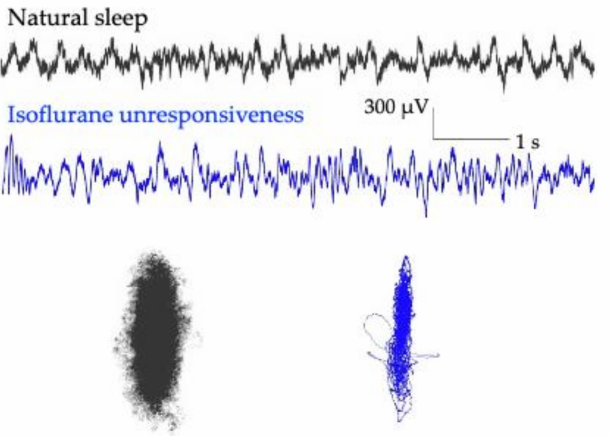
Figure 3. Rodent prefrontal local field potential activity and three-dimensional attractors during natural sleep and anesthesia. Local field potentials show less high frequency activity and more pronounced delta activity during anesthesia with isoflurane (blue) compared to natural sleep (black). Additionally, attractors generated from this activity show more pronounced flattening during isoflu- rane unresponsiveness (blue) compared to natural sleep (black), in the same animal. Adapted here with permission from Reference